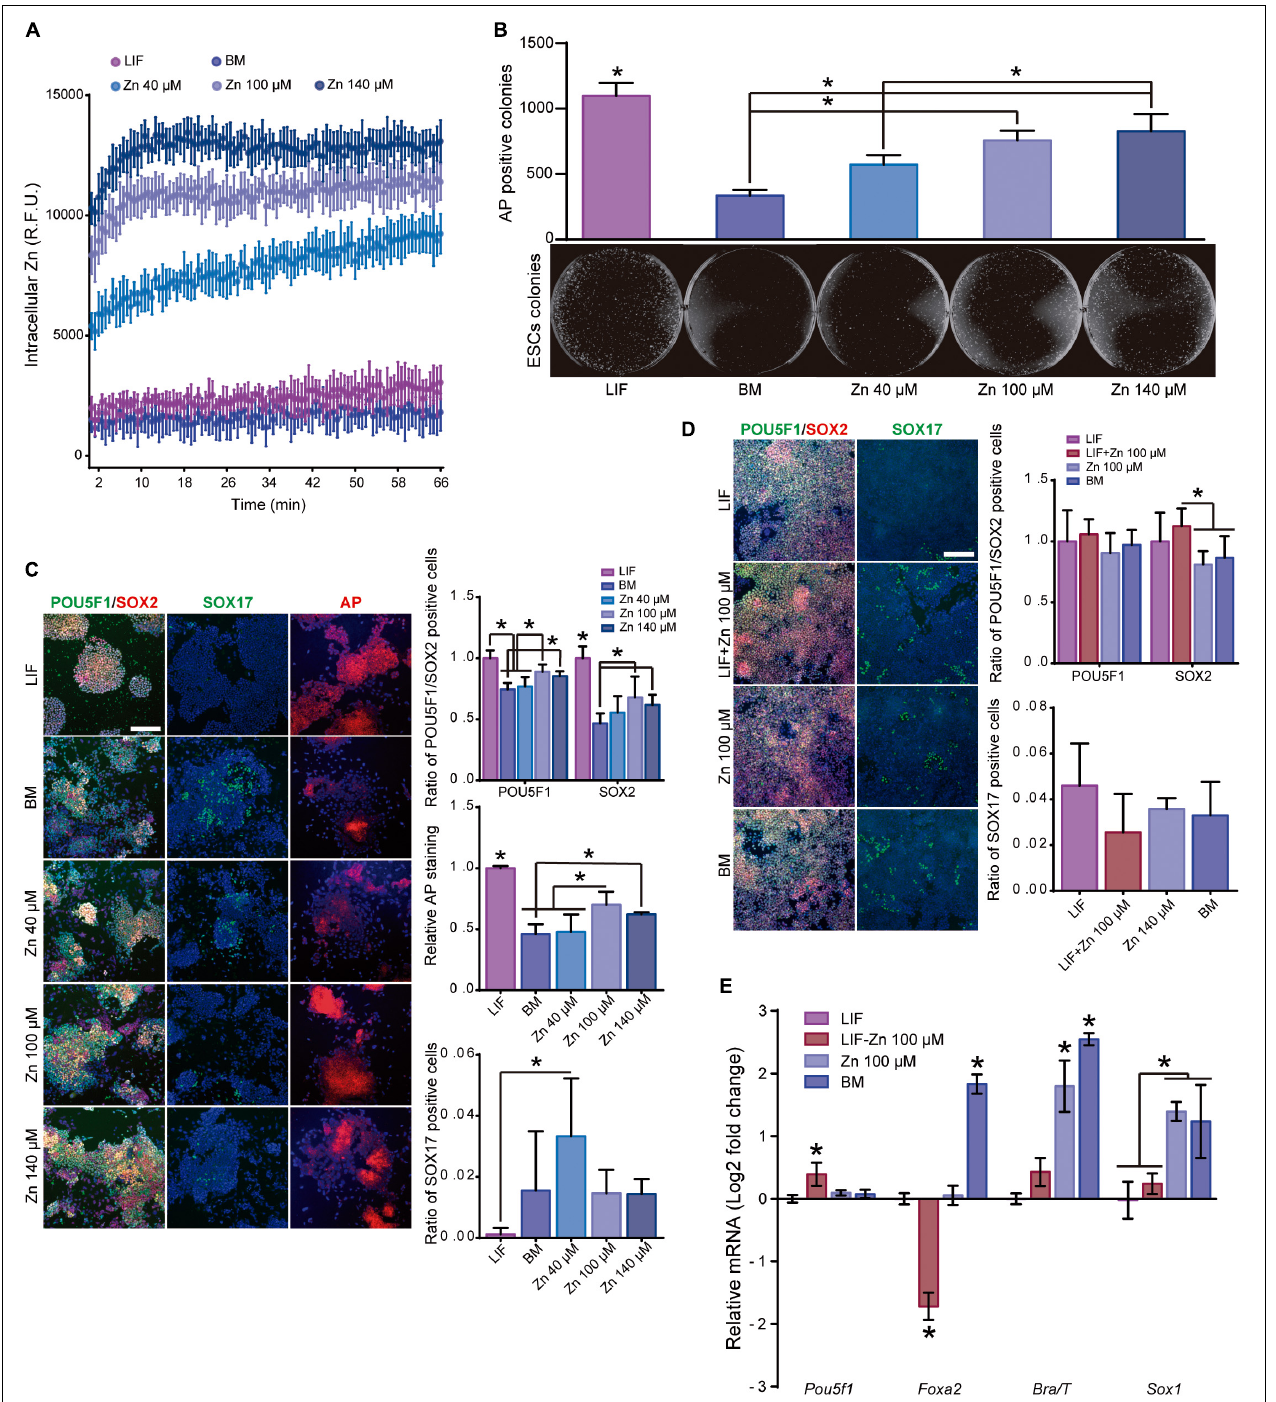
FIGURE 1 | Role of zinc in ESC self-renewal. (A) Intracellular Zn 2 + wave determined by FluoZin3-AM labeling (data points were taken every 40 s). Cells were kept at 37 ◦ C throughout the analysis ( n = 6). (B) AP staining of ESCs after 5 days of culture in BM, medium supplemented with LIF or medium supplemented with different concentrations of Zn 2 + ( n = 3). (C) Immunofluorescence detection of pluripotency markers (POU5F1 and SOX2) and staining of AP in ESCs after 5 days of culture in BM, medium supplemented with LIF or medium supplemented with different concentrations of Zn 2 + ( n = 5). (D) Immunofluorescence detection of pluripotency (POU5F1 and SOX2) and differentiation markers (endoderm: SOX17) determined after 5 days of culture in accelerated differentiation conditions (medium supplemented with 5% KSR) ( n = 5). (E) qPCR detection of pluripotency markers ( Pou5f1 ) and differentiation markers (endoderm: Foxa2 , mesoderm: Brachyury/T and ectoderm: Sox1 ) determined after 5 days of culture in accelerated differentiation conditions (medium supplemented with 5% KSR). Gapdh was used as housekeeping gene ( n = 4). Significant differences were determined by ANOVA test; ∗ p < 0.05. Scale bar: 200 µ m.